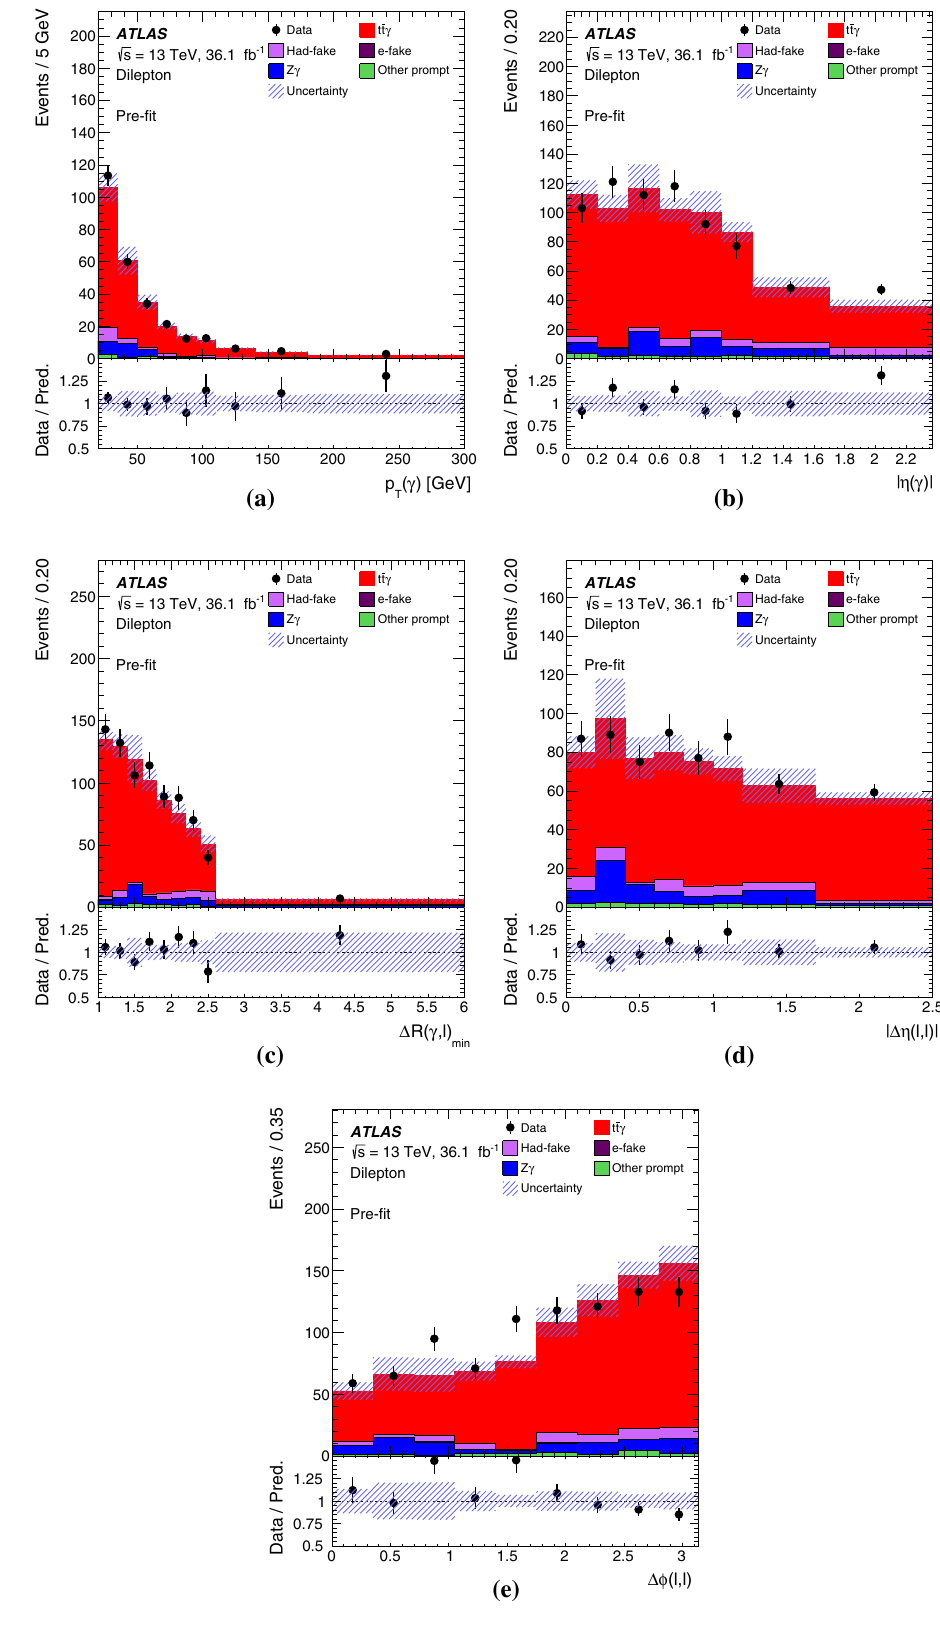
Fig. 2 Distributions of the a photon p T , b photon | η | , c minimum (cid:7) R (γ,(cid:8)) , d | (cid:7)η((cid:8),(cid:8)) | , and e (cid:7)φ((cid:8),(cid:8)) in the dilepton channel after event selection and before likelihood fit. All data-driven corrections and systematic uncertainties are included. Overflow events are included in the last bin.